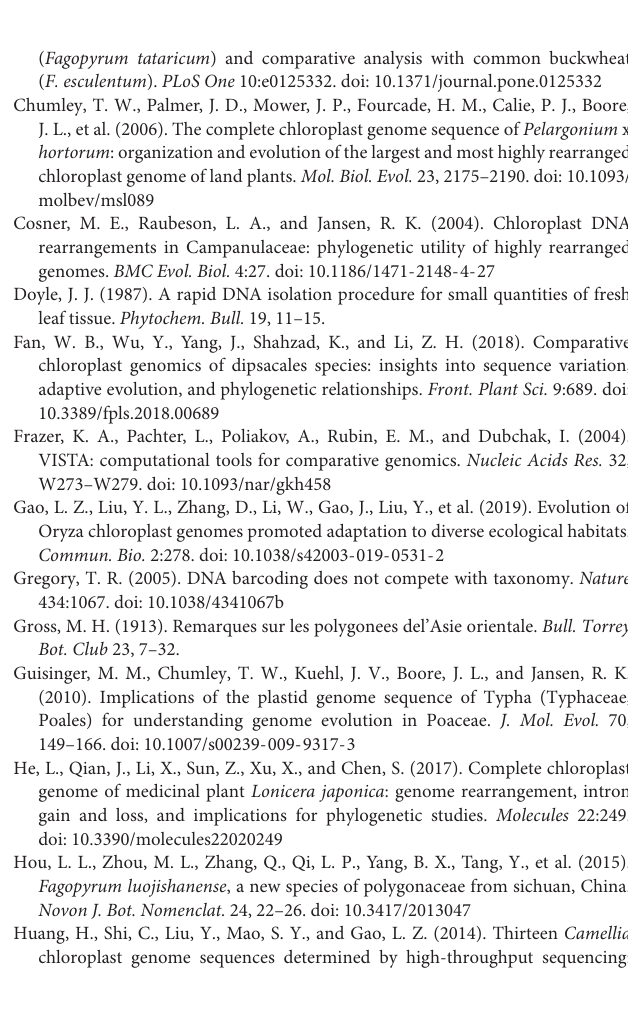
Supplementary Figure S1 | Phylogenetic tree based on the ndhF-rpl32 (A) , psbD (B) , trnC (C) , trnE-trnT (D) , trnS-trnG (E) , and trnV (F) sequences of eight Fagopyrum species constructed from NJ